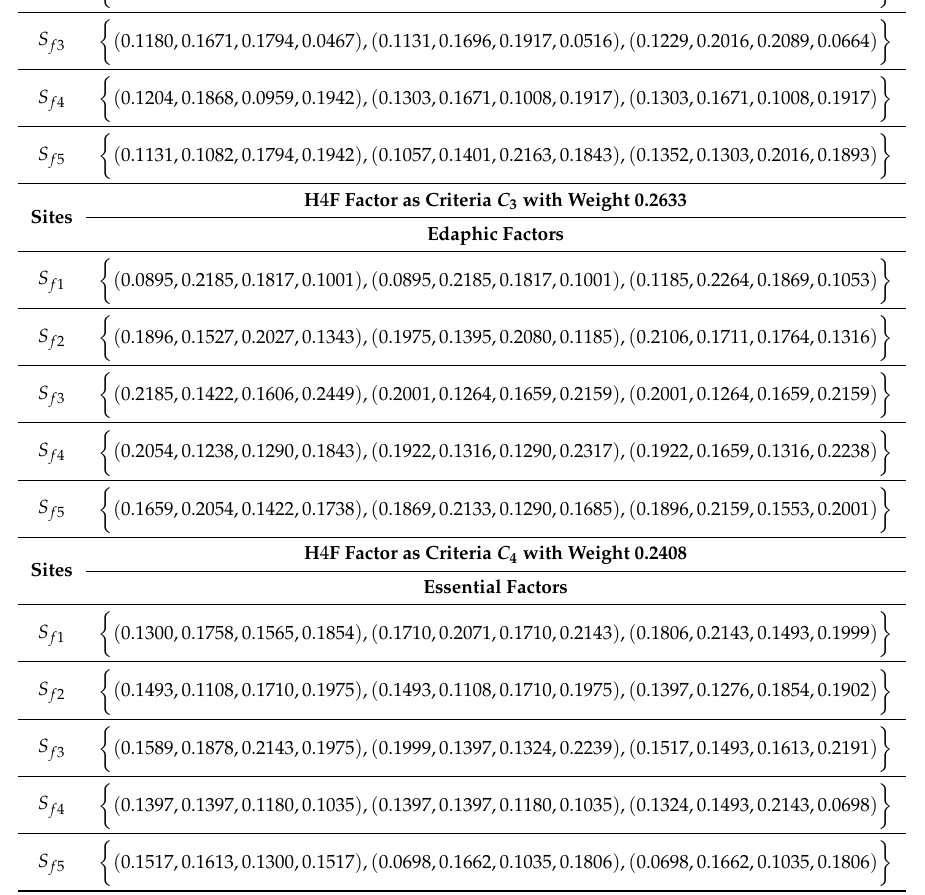
H 4 F Factor as Criteria C 2 with Weight 0.2458 Socio-Economic Factors